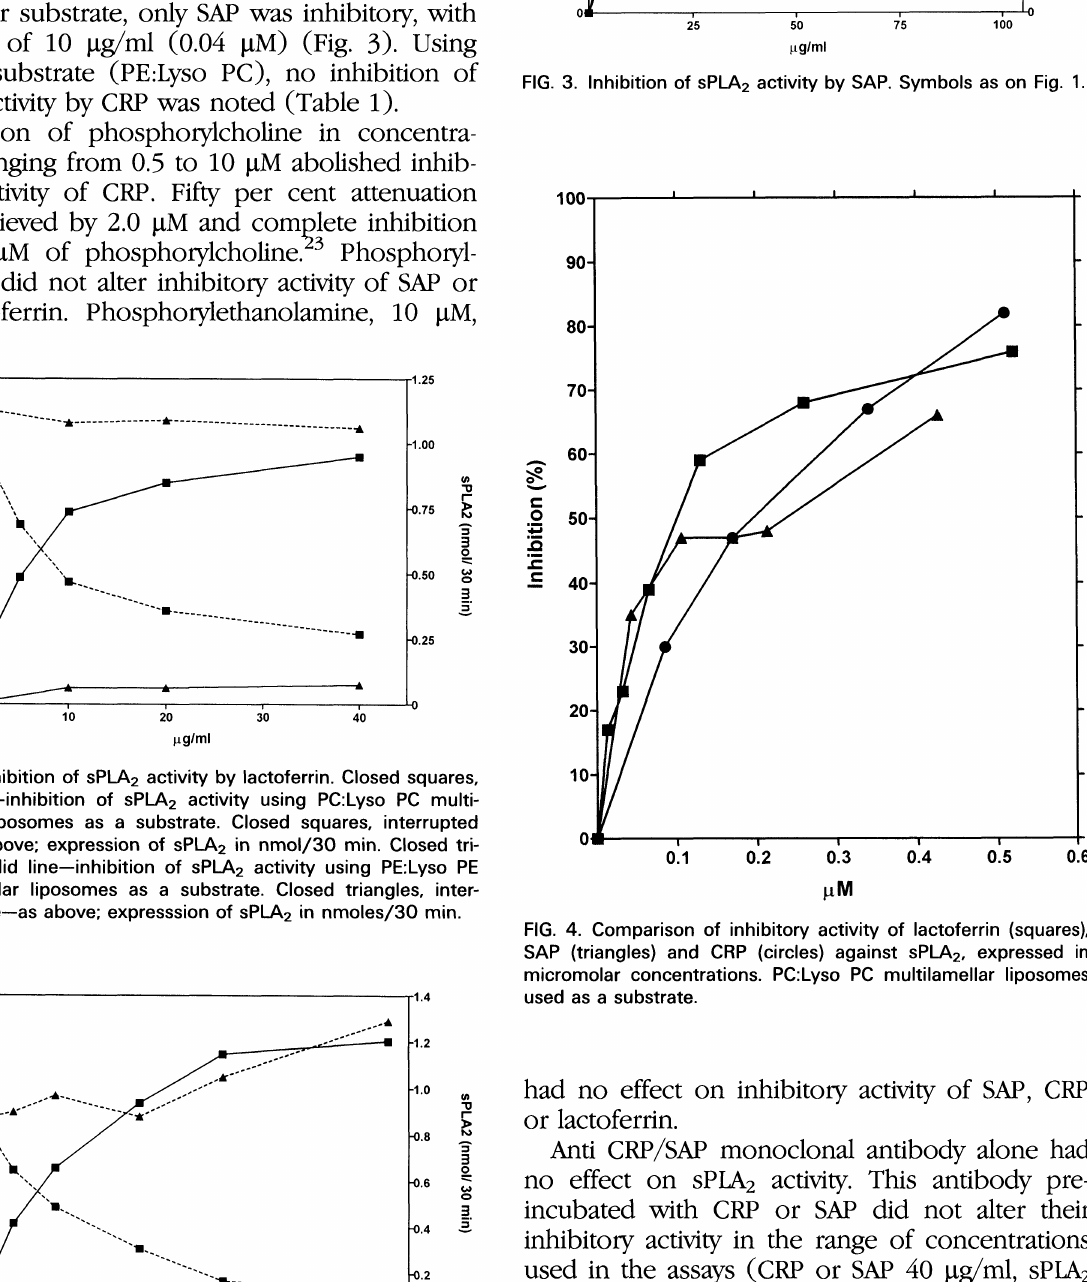
FIG. 2. Inhibition of sPLA2 activity by CRP. Symbols as on Fig. 1. 198 Mediators of Inflammation Vol 5 1996